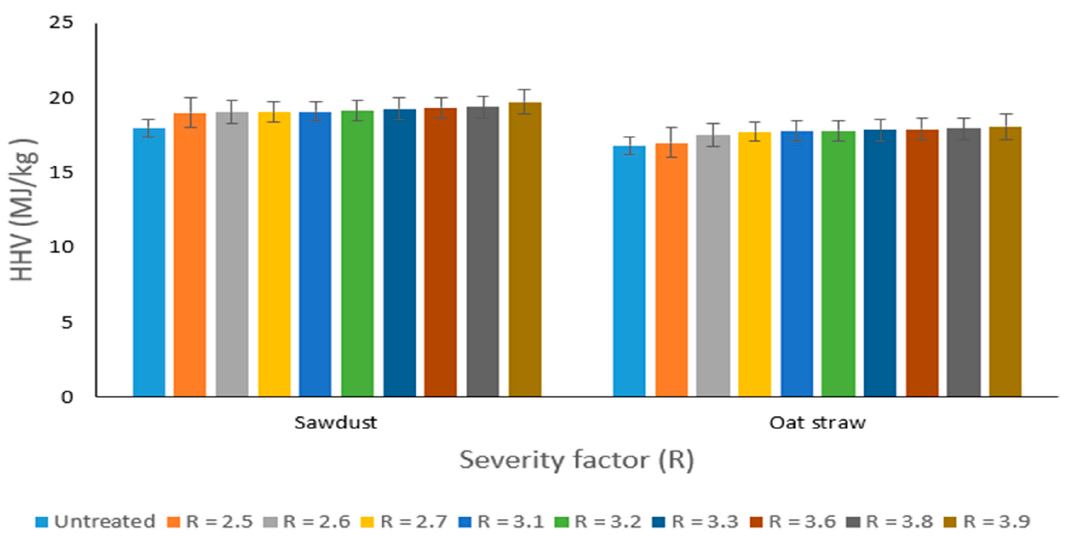
Figure 3. Higher heating value of steam-exploded and untreated biomass under different severities.